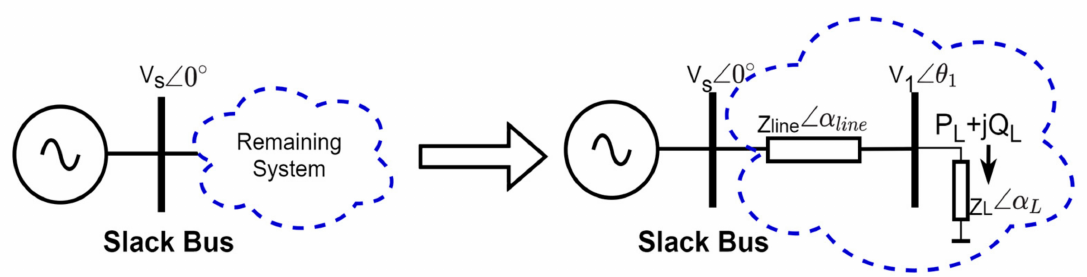
Figure 4. A typical two-bus system for load and transmission line equivalent admittance method.